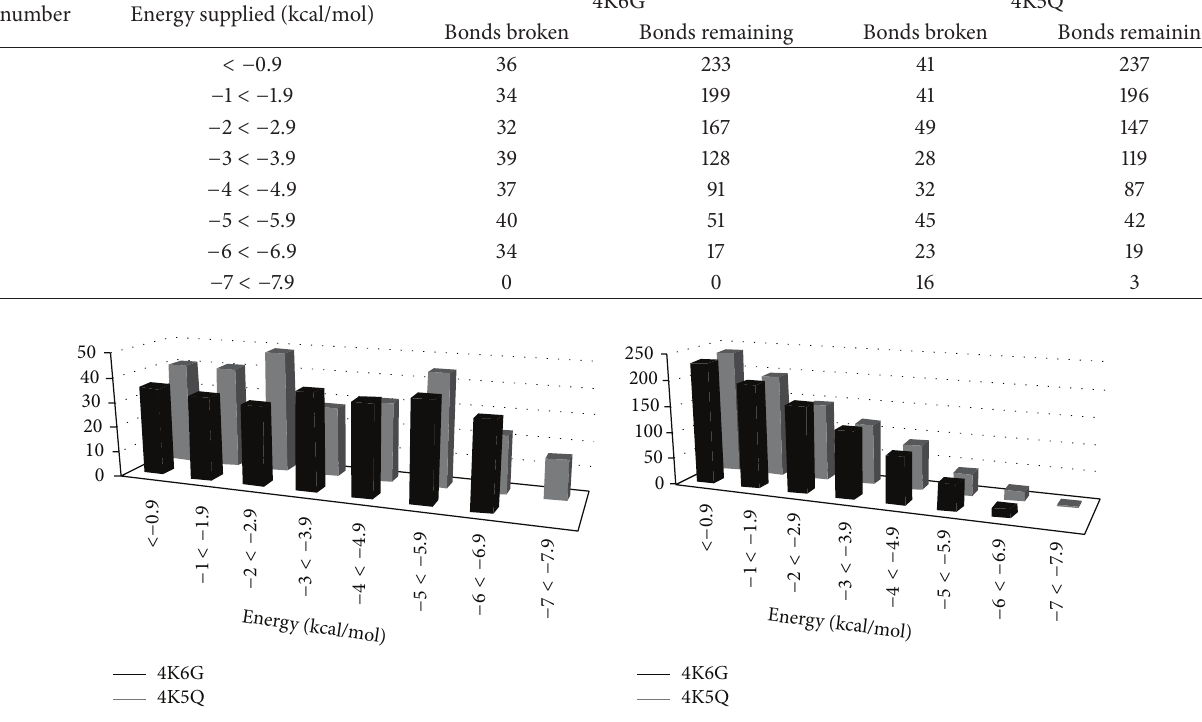
Table 1: Hydrogen bond dilution data of native (4K6G) and mutant (4K5Q) CALB showing the number of bonds broken and the number of bonds remaining to be broken at different energy profile.